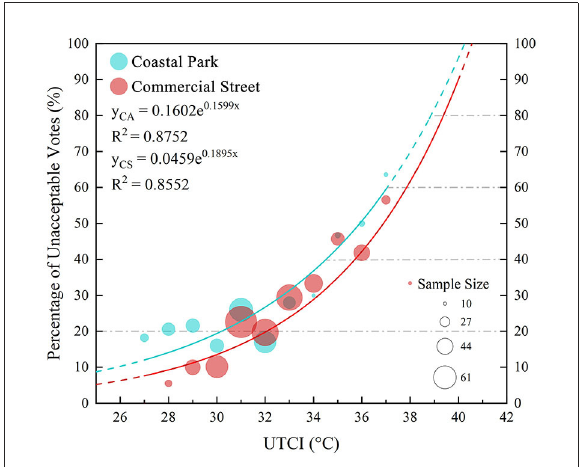
FIGURE8 Relationship between the thermal unacceptable rate and UTCI for the coastal park and commercial street.